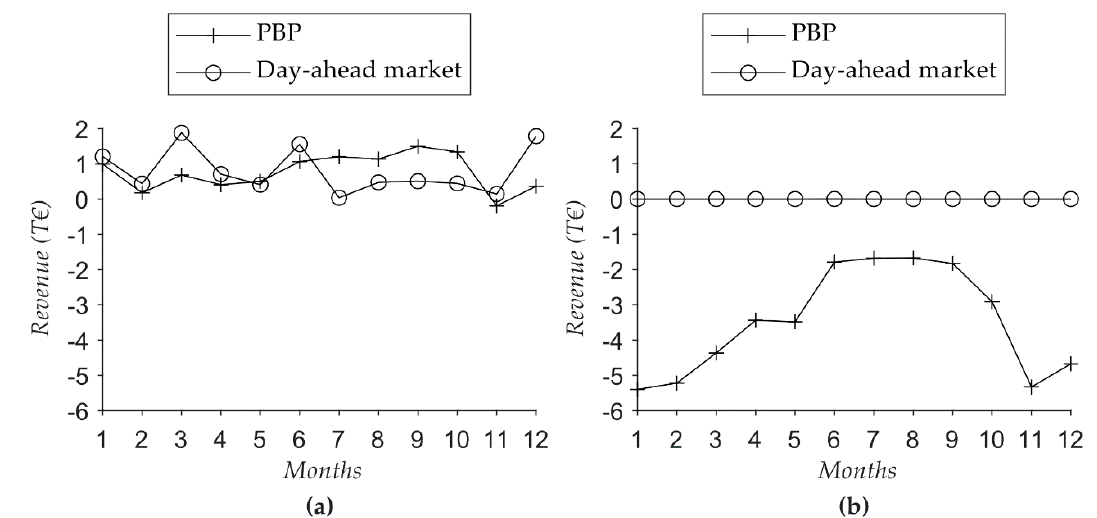
Figure 9. Revenues through storing energy inherently: ( a ) Optimal bidding strategy and minimum taxes; ( b ) Optimal bidding strategy and maximum taxes.